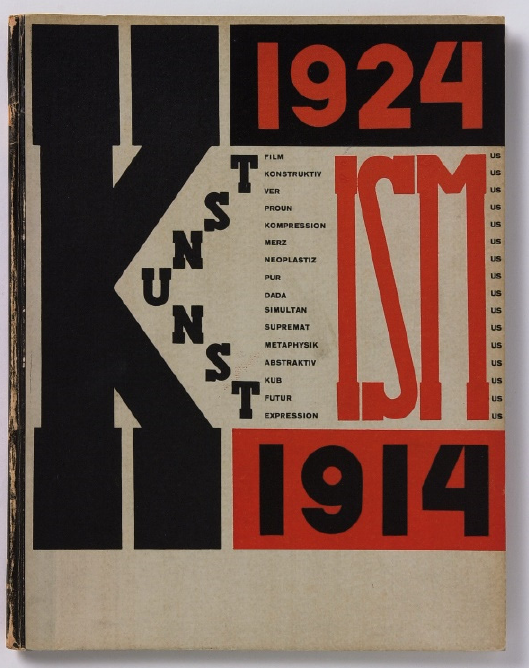
Figure 8. El Lissitzky and Hans Arp, ‘Kunstismen 1914–1924’, Zürich, 1925 (Lissitzky and Arp 1925). Van Abbemuseum. Photo: Peter Cox.